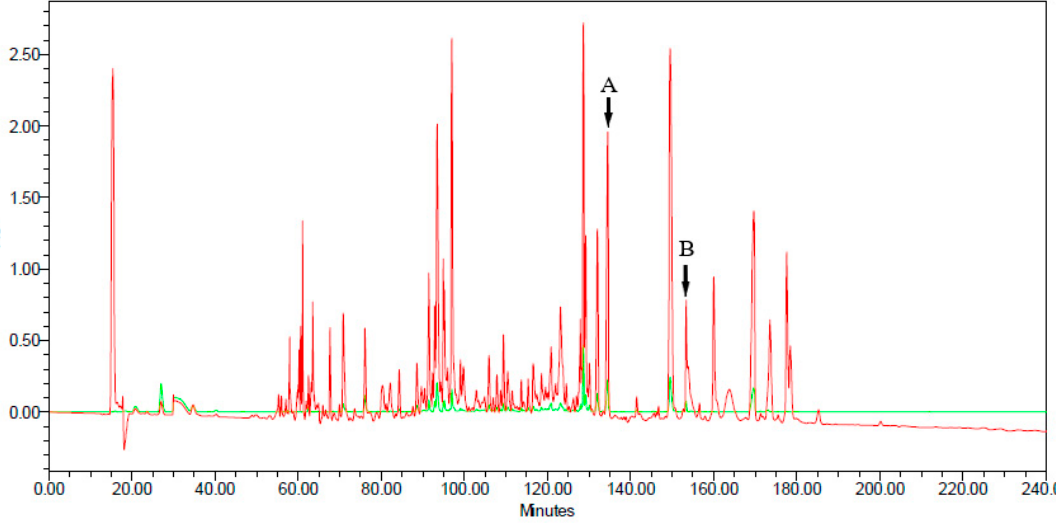
Figure 1. Reverse phase HPLC elution profile of skin secretion from Agalychnis spurrelli run over 240 min. Detection at 214 nm (red line); detection at 280 nm (green line). Letters A and B indicate the peak containing dermaseptin-SP2 and peak containing phylloseptin-SP1, respectively.